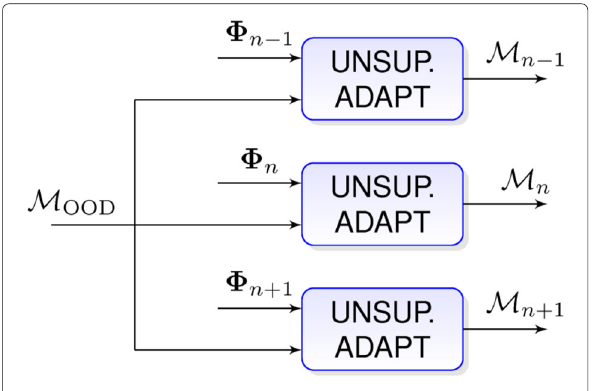
Fig. 8 Schematic for unsupervised independent adaptation for the episodes n − 1, n , and n + 1. M OOD represents the out-of-domain model and M n − 1 , M n , and M n + 1 , and the adapted models for each episode. (cid:4) n − 1 , (cid:4) n and (cid:4) n + 1 are the i-vectors from each